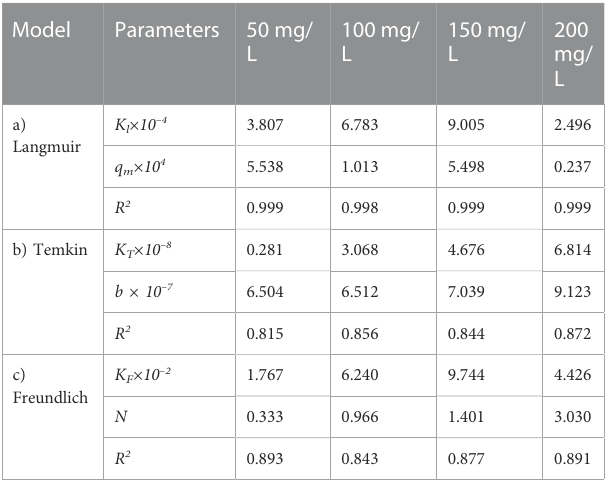
TABLE 15 Parameters of a) Langmuir, b) Temkin, and c) Freundlich isotherm models at different adsorbent amount using Oil sludge 4 as carbon active at T = 318 K and pH =